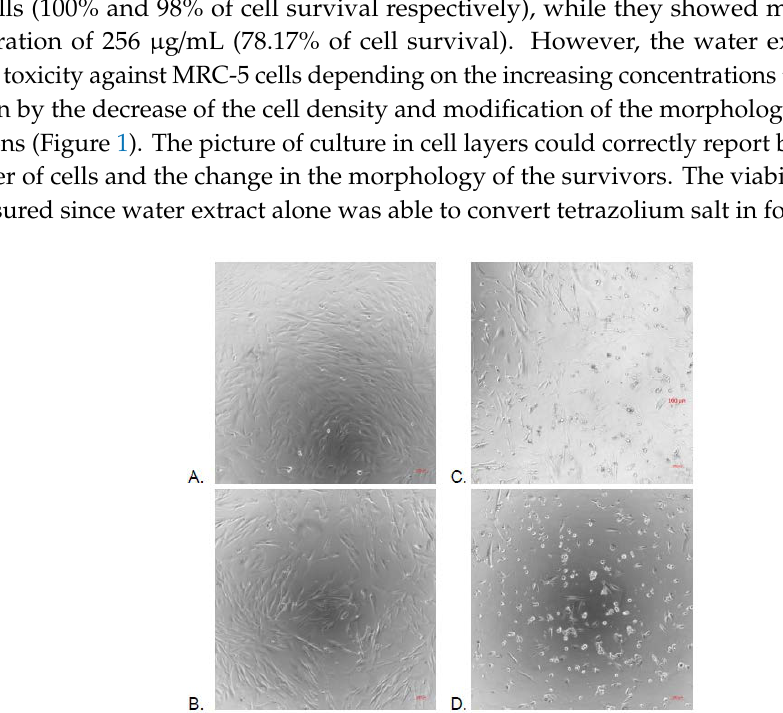
Figure 1. Microscopic observation of the effect of water Acacia seyal extract at different concentrations on MRC-5 cells at 24 hours. ( A ): DMSO control, ( B ): 64 μg/mL, ( C ): 128 μg/mL, ( D ): 256 μg/mL, observation under ×10 air objective.